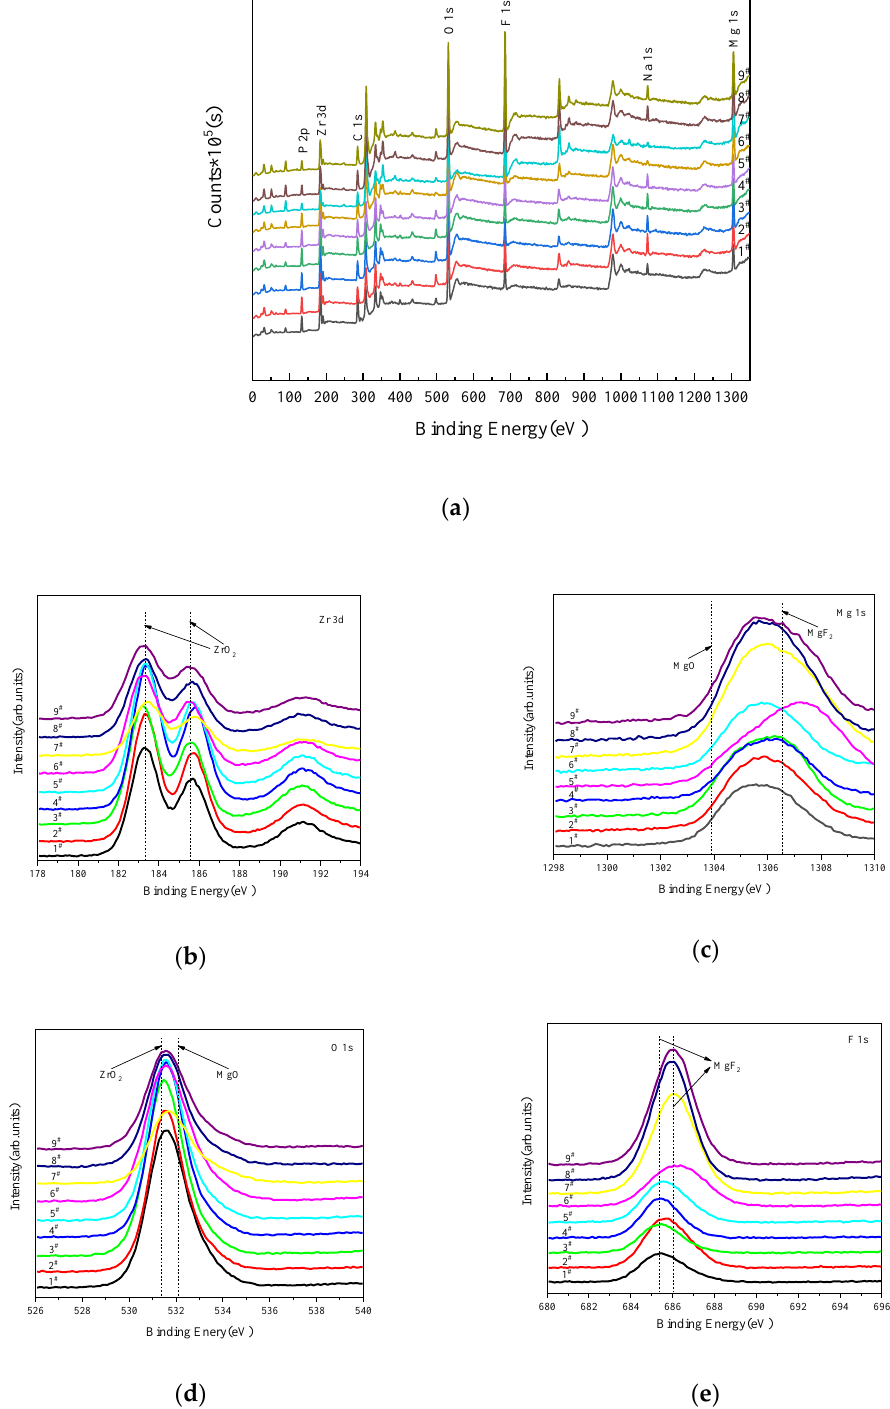
Figure 8. XPS analysis of MAO coatings formed in orthogonal experiment: ( a ) XPS survery spectra, ( b ) Zr 3d; ( c ) Mg 1s; ( d ) O 1s; ( e ) F 1s.